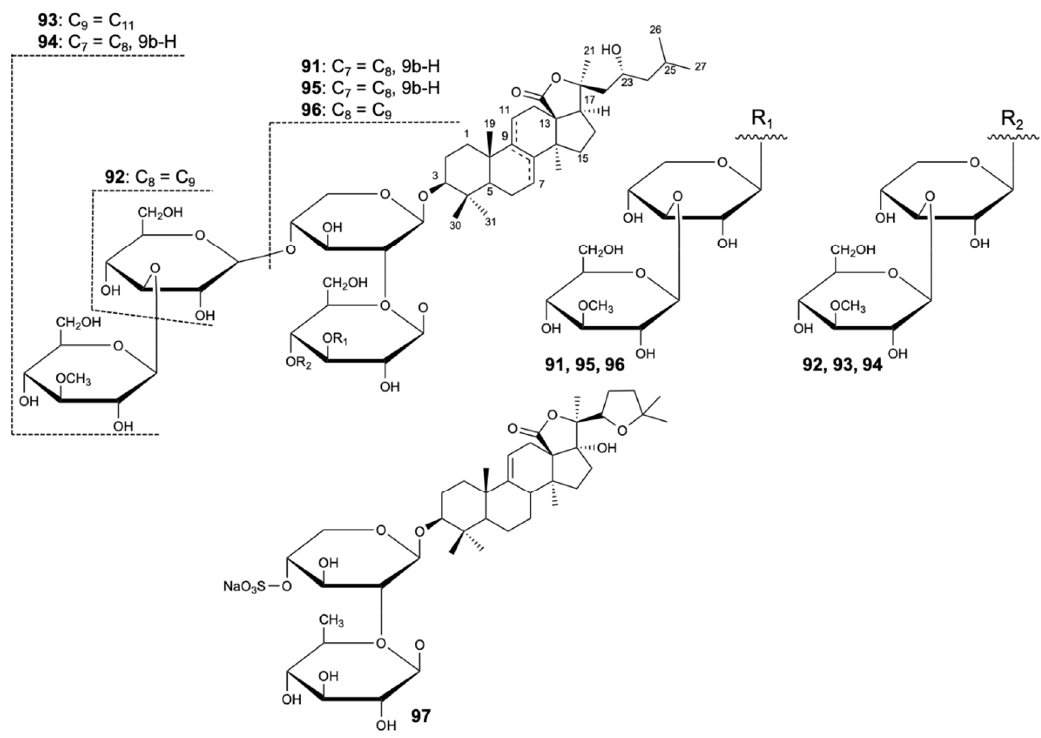
Figure 23. Structures of compounds 91 – 97 .